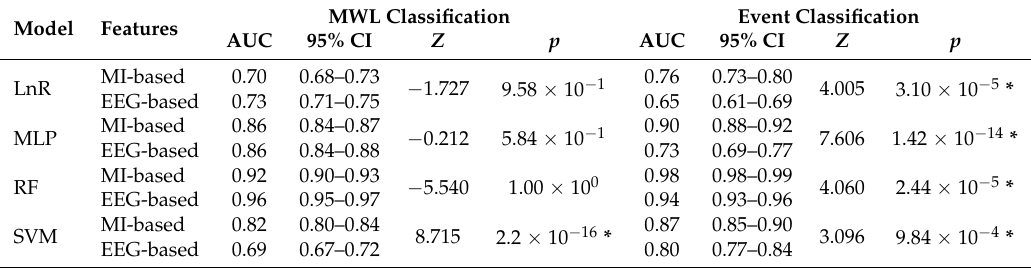
Table 6. Summary of DeLong’s test [75] to compare Area Under the Curve (AUC) values at significance